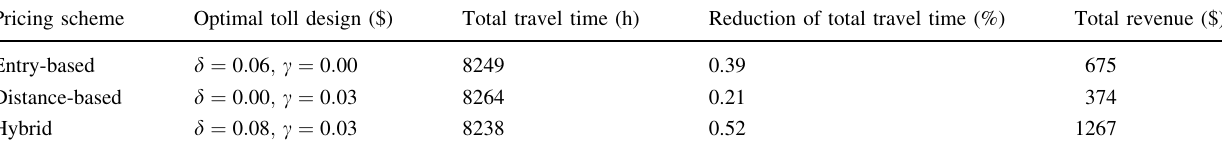
Table 5 Optimal designs of cordon pricing schemes with revenue restriction of 2 9 10 3 $ for Sioux Falls Pricing scheme